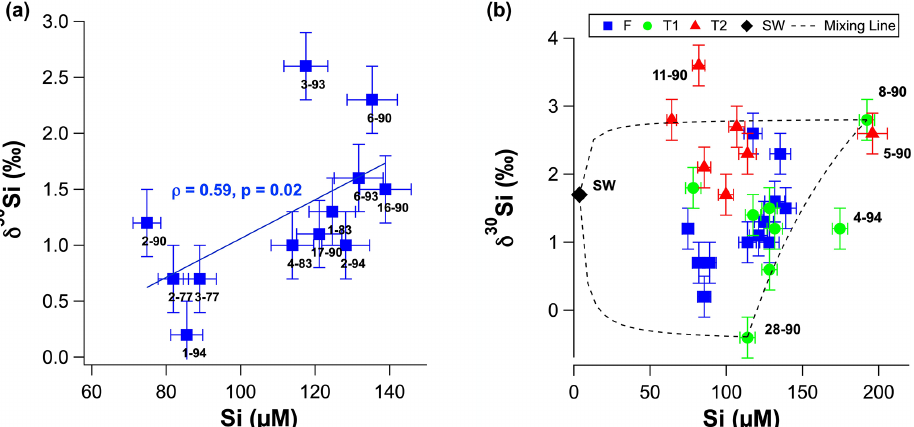
Figure 4. (a) Groundwater δ 30 Si values as a function of molar dSi concentrations for fresh groundwater. (b) Groundwater δ 30 Si values as a function of molar dSi concentrations T1 (green circles) and T2 groundwater (red triangles). Black dashed lines represent theoretical mixing between seawater, well 8–90 and well 28–90. The seawater δ 30 Si value was assumed to be + 1.7‰, based on the average value for the low-concentration seawater sample from Grasse et al. (2017). Sample IDs are shown next to markers for all samples in (a) and selected samples in (b)